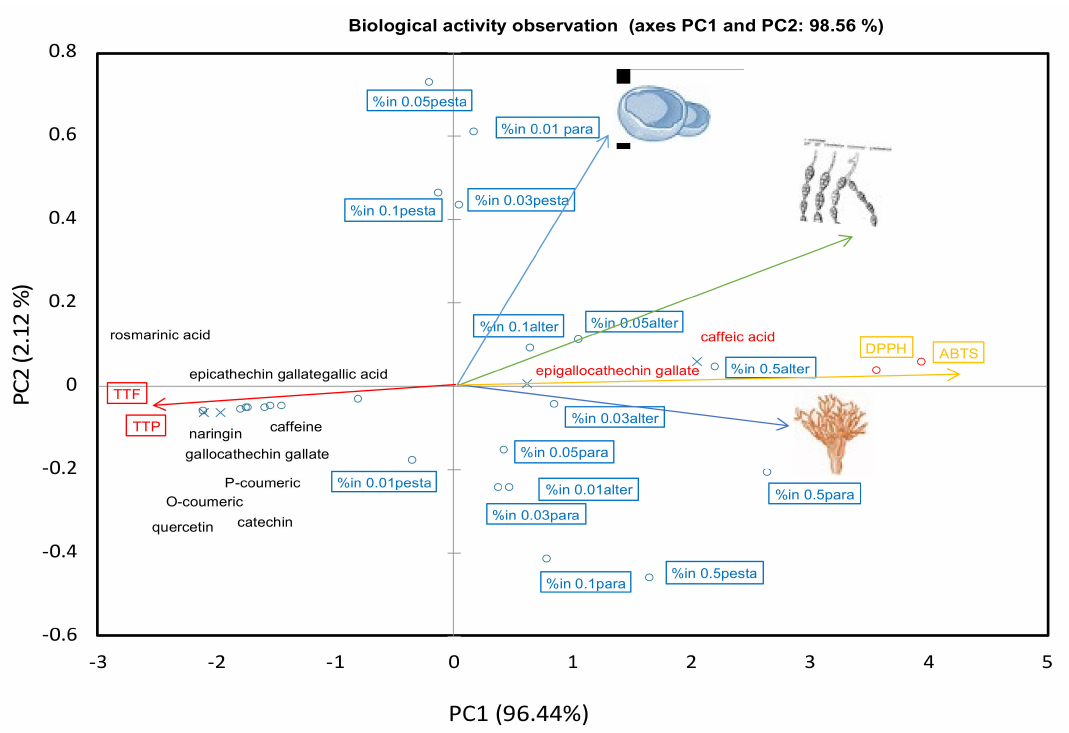
Figure 5. Chemometric score plot of the antifungal activities described as percentage of inhibition (%in) of Alternaria brassicicola (CRC152), Pestalotiopsis sp. (CRC151) and Paramyrothecium breviseta (CRC12) in different concentrations of crude methanolic extracts of coffee pulp 0, 0.01, 0.03, 0.05, 0.1 and 0.5 g/mL. Abbreviations; alter = Alternaria spp.; pesta = Pestalotiopsis spp.; para = Paramyrothecium spp.; TTF = total flavonoid content; TTP = total phenolic